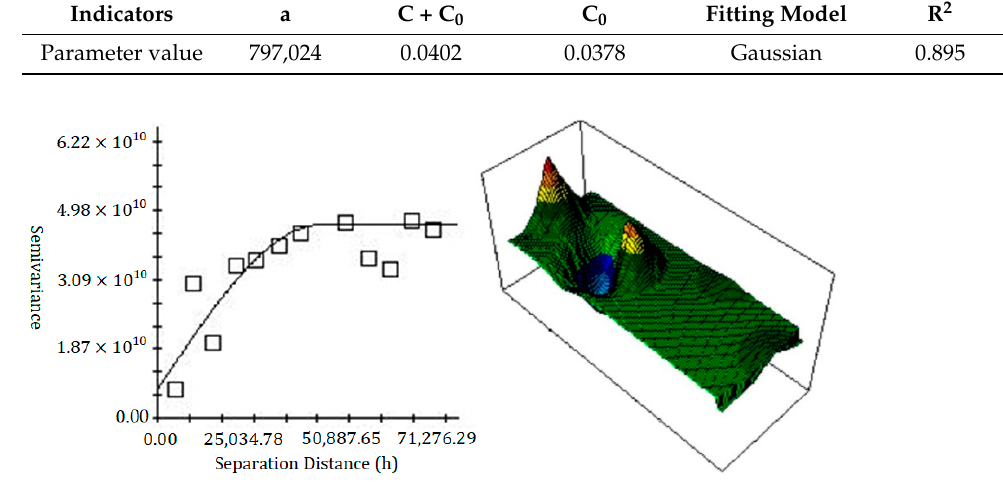
Figure 6. Variation function diagram of rural settlement morphology distribution in Nanjing.